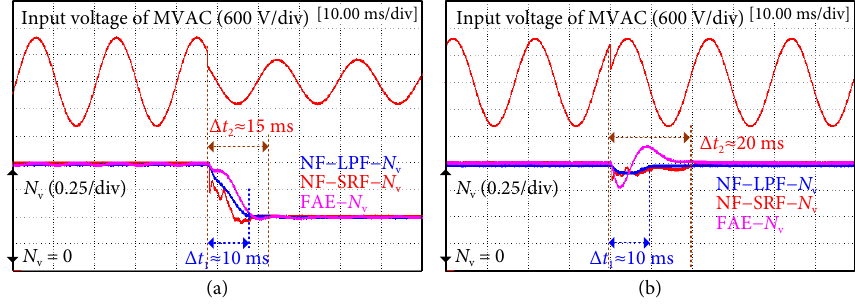
Fig. 15 Experimental results. (a) Voltage sag of 0.5 p.u. and frequency jump of 1 Hz. (b) Phase sudden change of